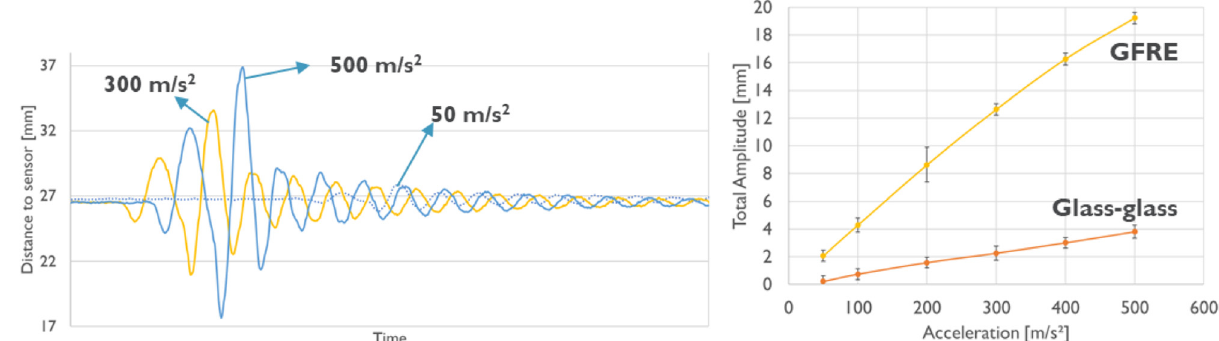
Fig. 6. Measurement of the de fl ection of the centre of the laminate during shock impact testing for accelerations of 50, 300 and 500m/s 2 (left) and (mostly linear) increase of amplitude with increasing acceleration for GFRE vs glass-glass reference laminates.